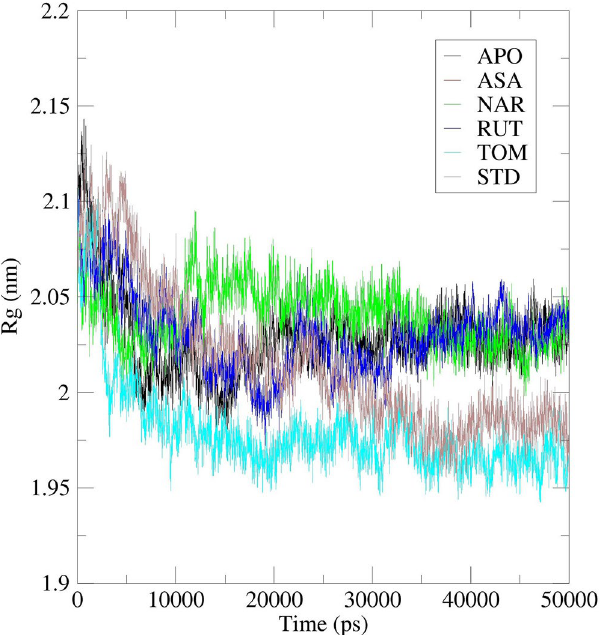
Figure 13. Radius of gyration study plot for 50 ns MD Simulation of 7AQB-APO (Black), 7AQB-ASA (Red), 7AQB-NAR (Green), 7AQB-RUT (Blue) 7AQB-TOM (Yellow) and 7AQB-STD (Brown).